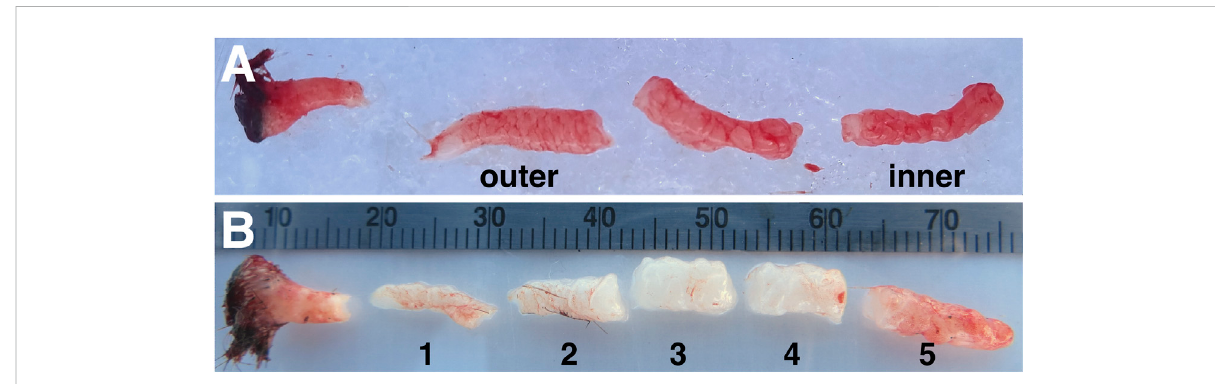
FIGURE 1 Example of northern elephant seal blubber biopsies used for (A) transcriptome analyses and (B) targeted gene expression assays. The former was collected from juvenile elephant seals and dissected into three layers; the innermost and outermost layers were used for transcriptomics. The latter was collected from weaned elephant seal pups and dissected into fi ve ~1-cm layers (numbered 1 – 5 from outer-to innermost). Differences in tissue color are due to differences in blubber perfusion in individual animals at time of